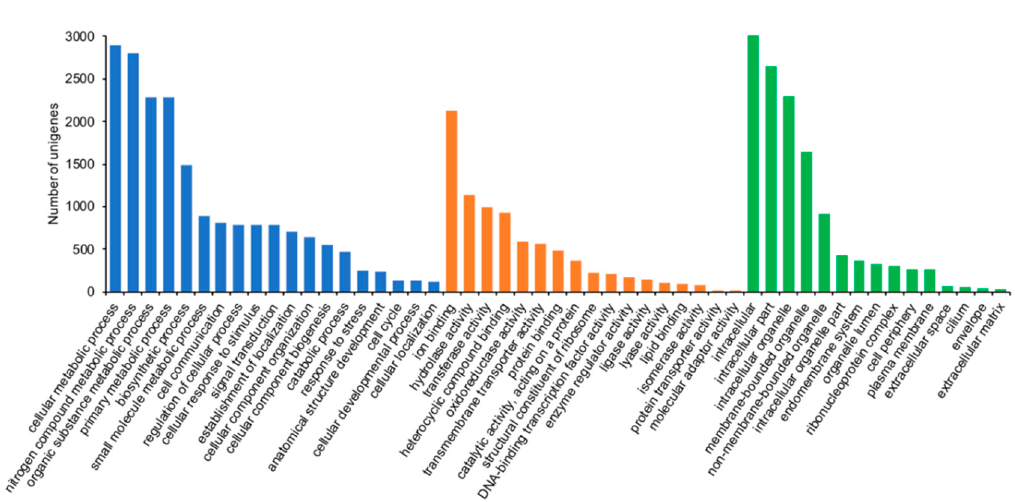
Figure 3. Gene Ontology (GO) classifications of the unigenes from the Z. subfasciatus transcriptome. Histogram shows the GO functional categories most represented based on level 3 analysis. Biological Process (blue bars), Molecular Functions (orange bars) and Cellular Component (green bars).